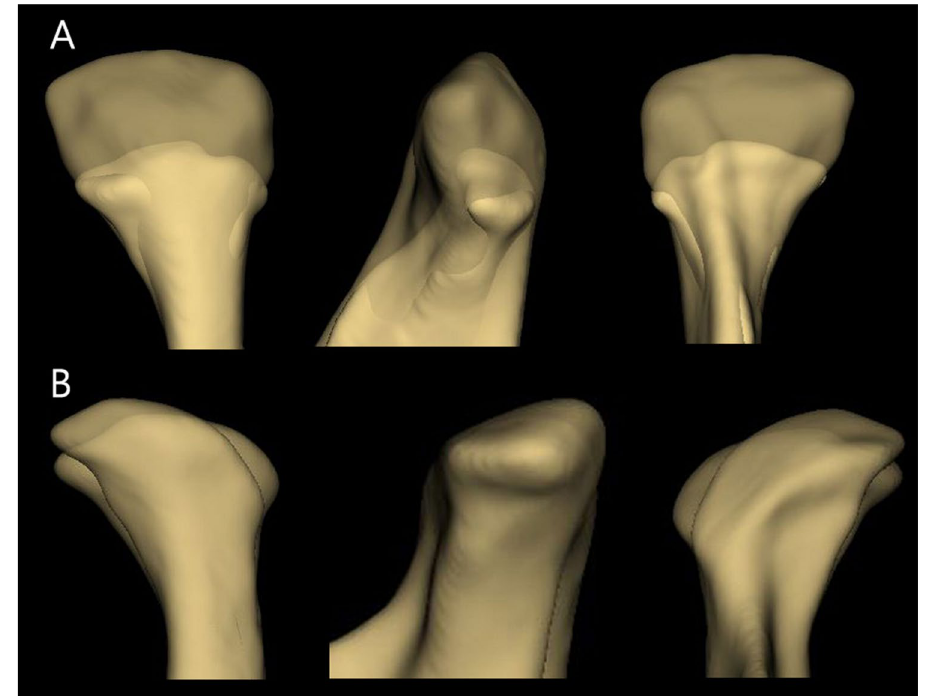
Figure 1. ( A ) Mandibular condyle with maximum resorption. ( B ) Mandibular condyle with maximum apposition, 3D slicer (v. 4.11.0, Slicer, http:// www. slicer.